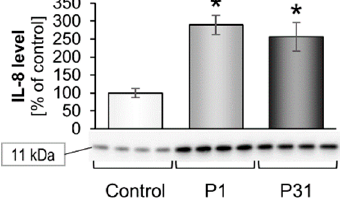
Figure 8. Influence of short-term microgravity on the protein accumulation of IL-8. The data is given as mean ± standard deviation. * p < 0.05 vs. Control.